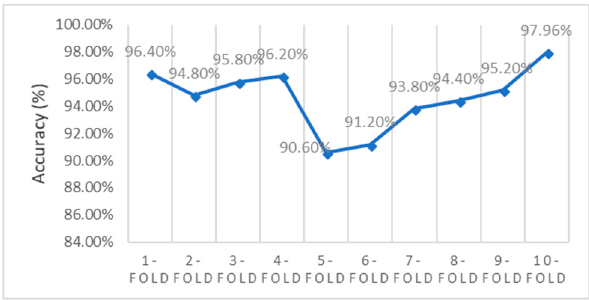
Figure 11. Prediction Accuracy Rate of EAGA method of Cross-Validation technique.